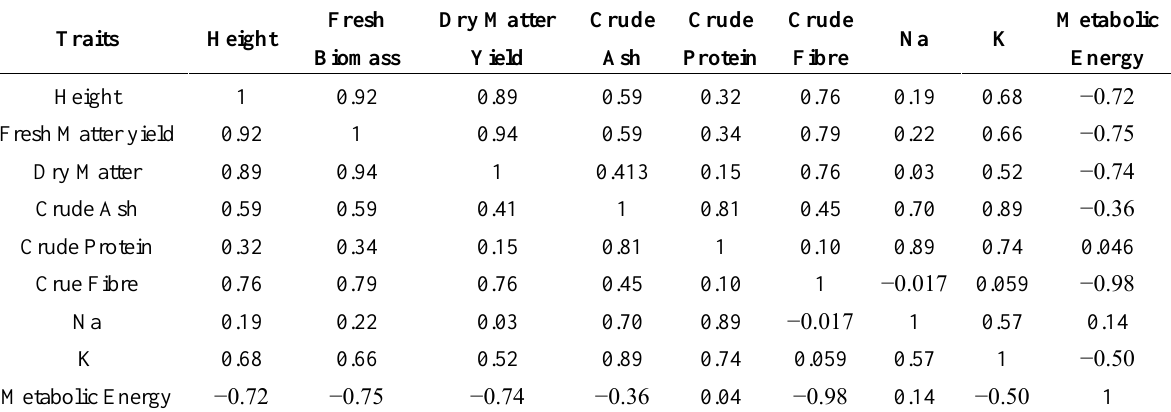
Table 2. Pearson coefficient of selected structural and biochemical traits of grassland in the May survey.